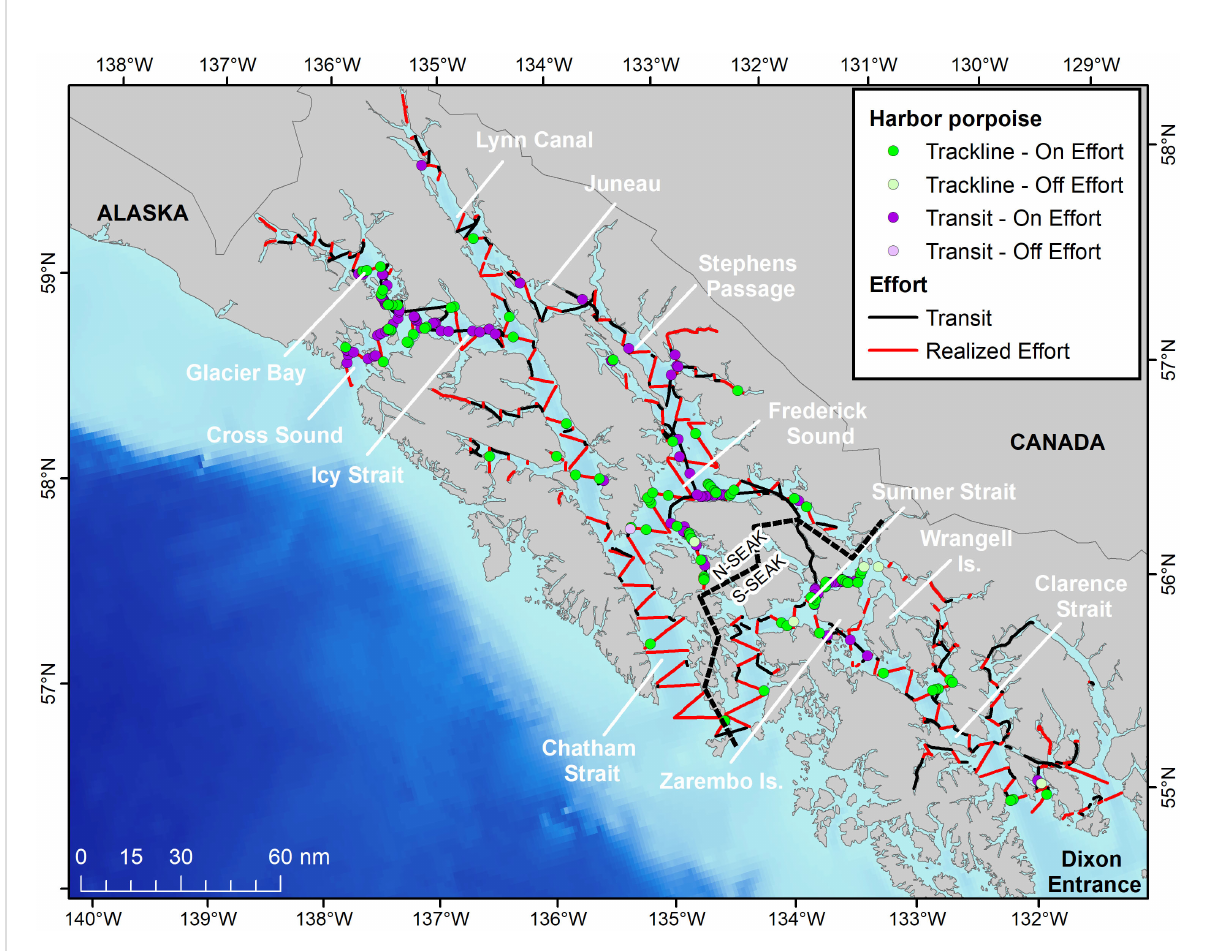
FIGURE 2 Harbor porpoise distribution during the 2019 SEAK survey. Porpoise groups detected on- and off-effort are indicated by darker and lighter green circles and realized effort is shown as red